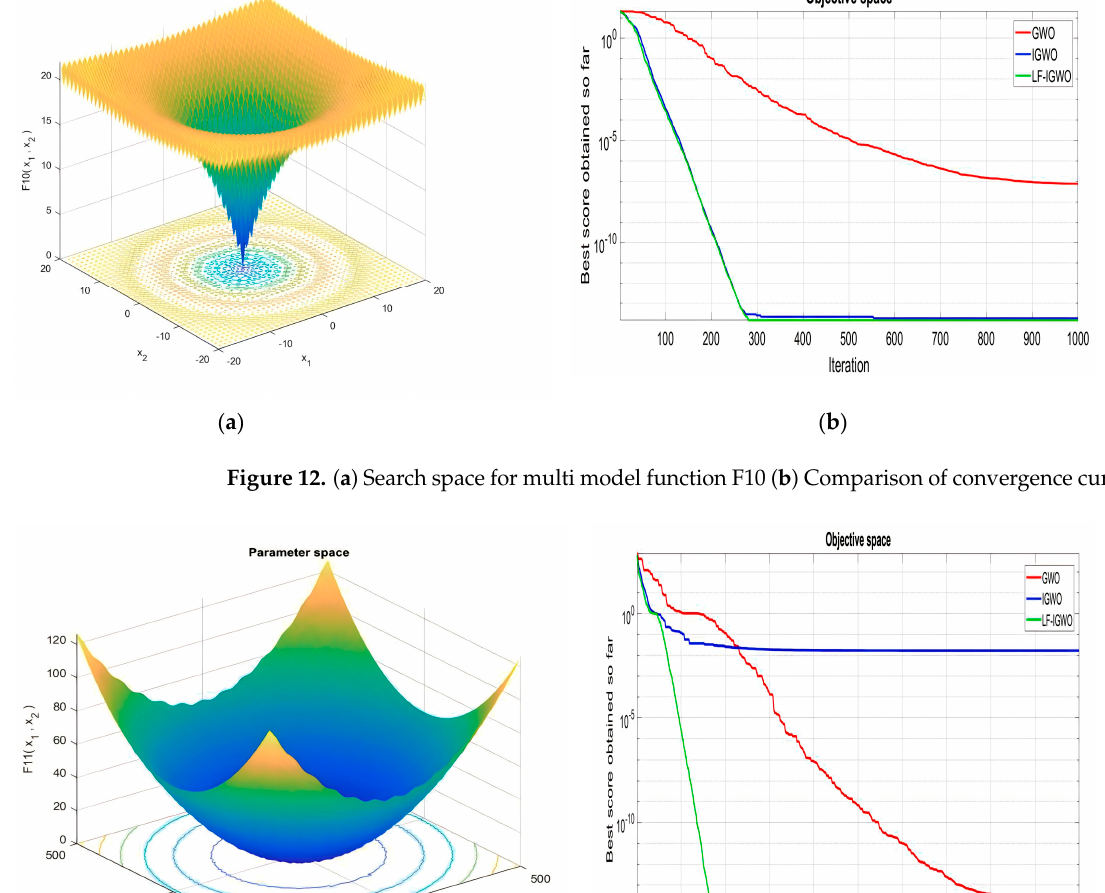
( b ) Figure 15. ( a ) Search space for multi model function F13 ( b ) Comparison of convergence curve for F13.